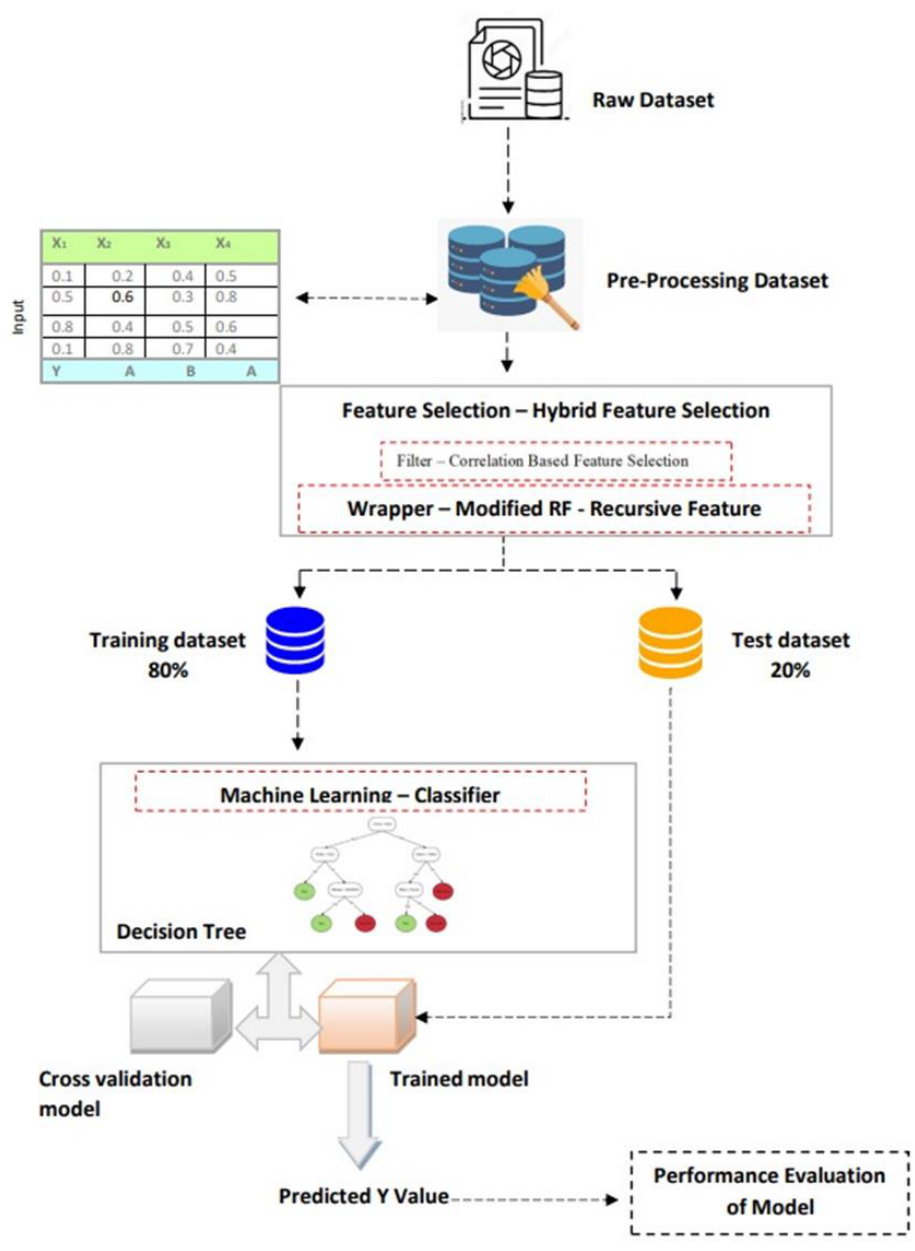
Figure 4. Water quality monitoring data processing workflow.